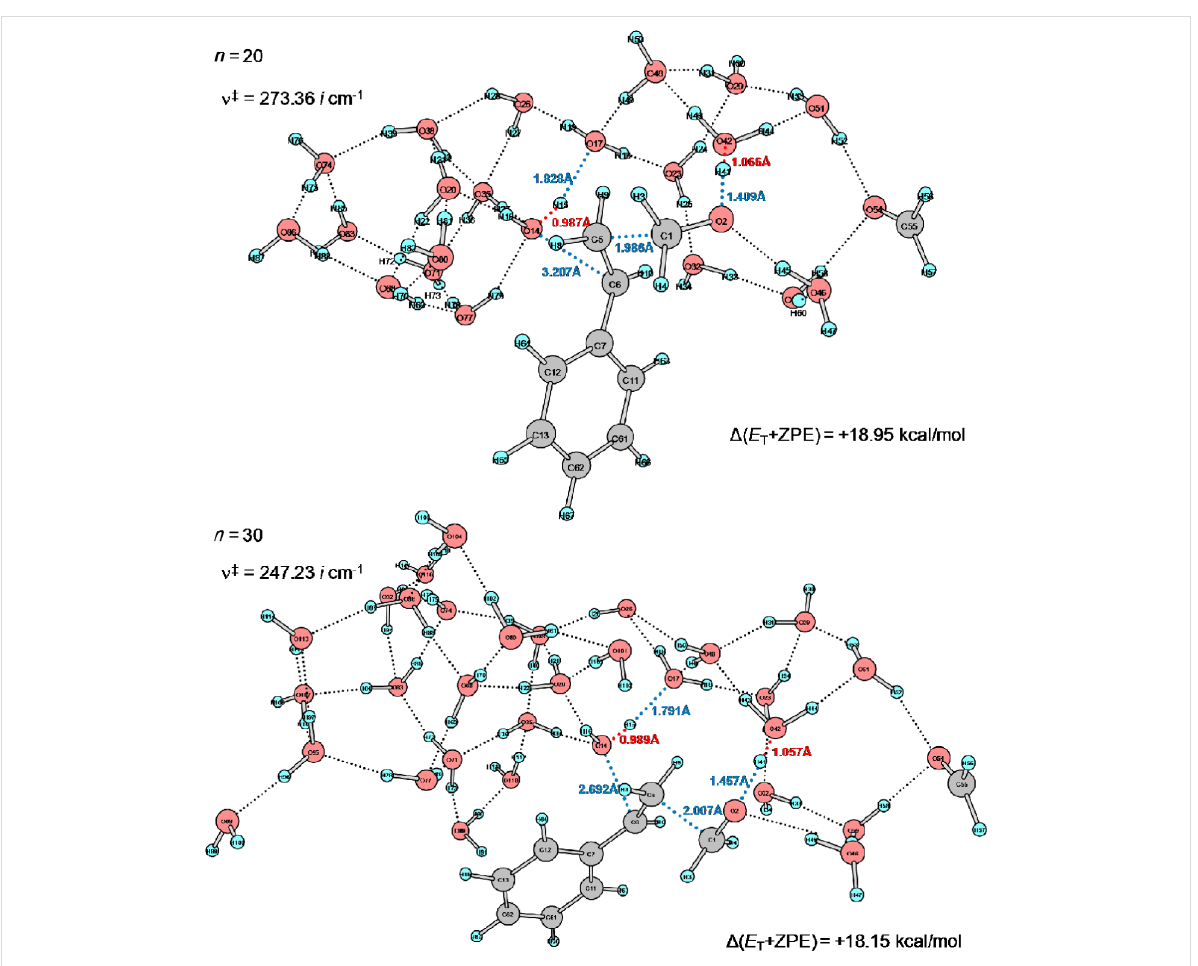
Figure 5: TS1(Ph) geometries of n = 20 and n = 30 in the reacting system of styrene + H 3 O + (H 2 O) n + (H 2 C=O) 2 calculated by